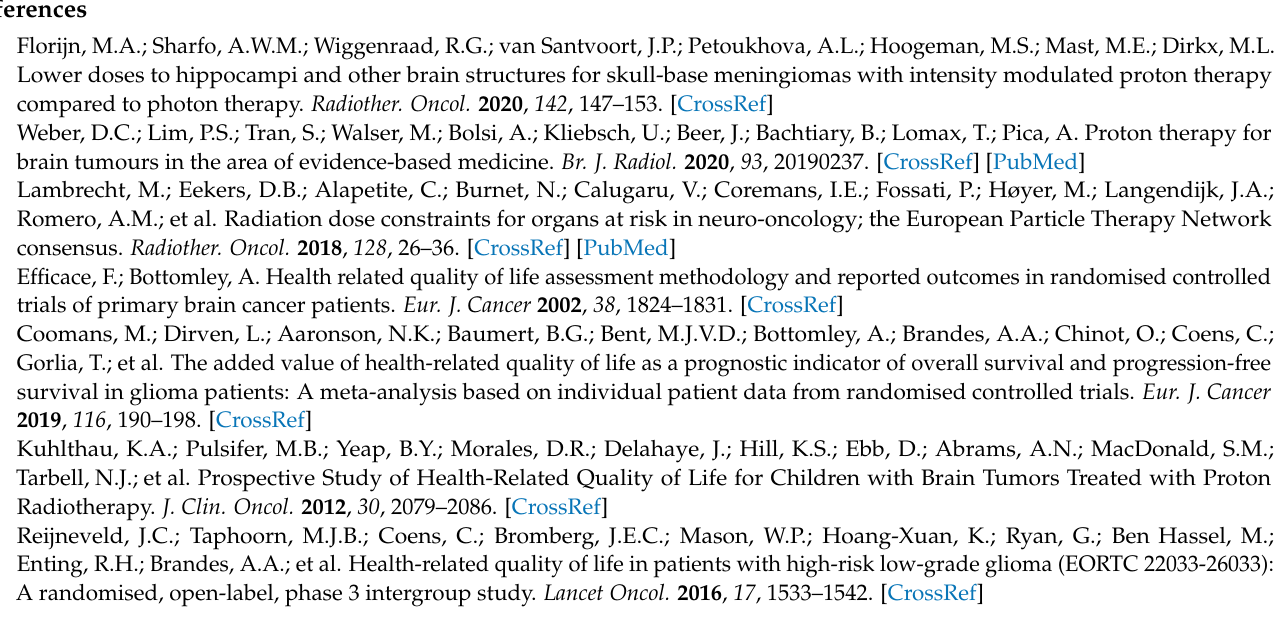
Supplementary Materials: The following are available online at https://www.mdpi.com/article/ 10.3390/cancers13194892/s1, Figure S1: EORTC QLQ-C30 function scores (mean ± SD) at baseline (T0), directly following PT (T1) and at 1 year (T2), 2 year (T3) and 3 year (T4) follow-up. Figure S2: EORTC BN20 function scores (mean ± SD) at baseline (T0), directly following PT (T1) and at 1 year (T2), 2 year (T3) and 3 year (T4) follow-up. Table S1: Friedman’s test to evaluate significant changes of reported scores from baseline to 3 year follow-up. A p -value of <0.05 shows a significant difference. Table S2: Overview of observed tumor/surgery-related toxicity directly before proton therapy (PT), PT-related acute ( ≤ 3 months) and late ( ≥ 3 months) toxicity, graded by use of Common Terminology Criteria for Adverse Events (CTCAE) v4.03. Numbers are represented as number of events